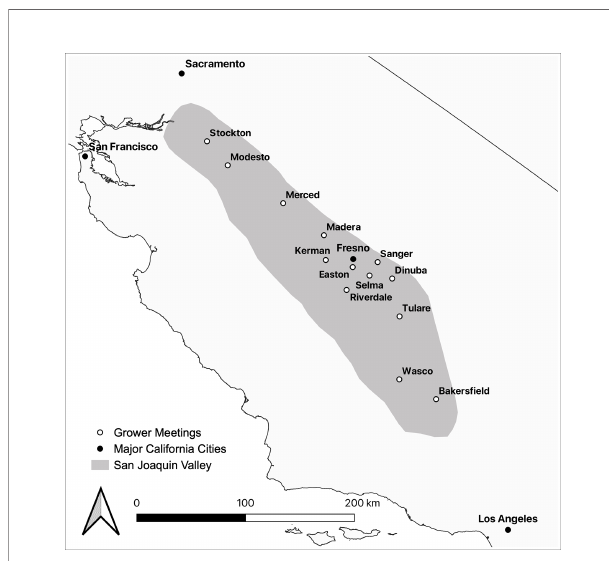
FIGURE 1 | Map display of in-person grower meetings locations where surveys were conducted in 2017 and 2018 within the San Joaquin Valley relative to major California